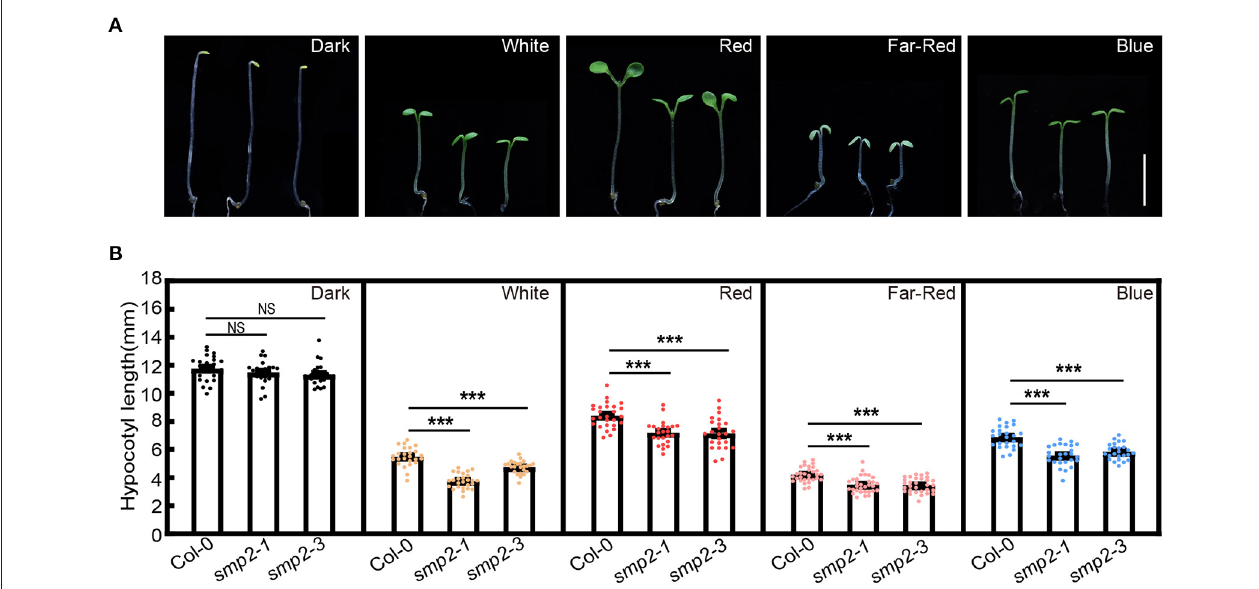
FIGURE 2 | smp2 mutants are hypersensitive to light. (A) Visual phenotypes of 5-day-old wild-type (Col-0) and smp2 seedlings grown in the dark or different light conditions. White light, 7.5 µ mol · m − 2 · s − 1 ; Red light, 47 µ mol · m − 2 · s − 1 ; Far-red light, 4.5 µ mol · m − 2 · s − 1 ; Blue light, 3.0 µ mol · m − 2 · s − 1 . Scale bars, 5mm. (B) Quantification of hypocotyl lengths of Col-0 and smp2 seedlings grown under conditions as indicated in (A) . Error bars represent standard deviation (SD), n ≥ 25; *** P < 0.001 ( t-test ); NS, not significant ( t-test ). Experiments were performed three times with similar results.